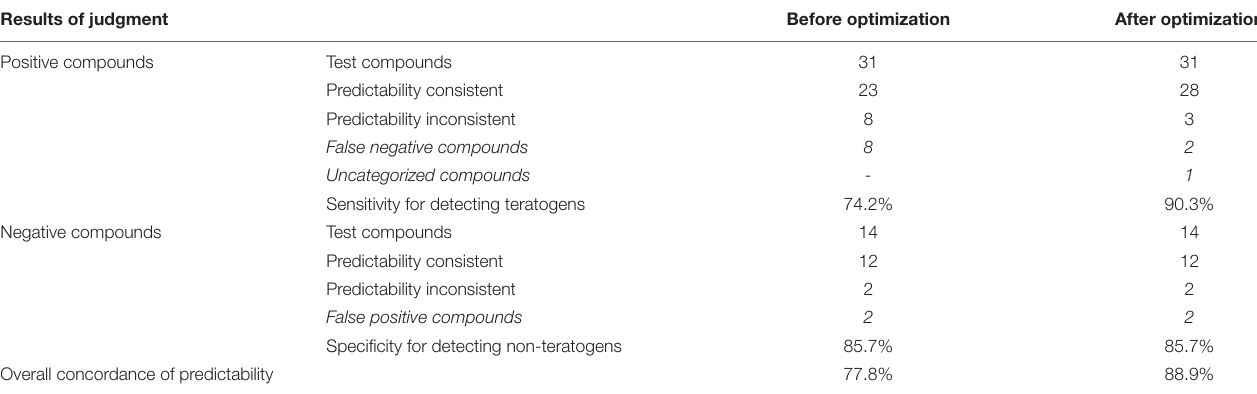
TABLE 5 | Comparison of prediction accuracy of zebrafish developmental toxicity assay before and after